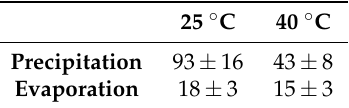
Table 7. The number of unit cells needed to have a total stack potential of 1.33 V and an operating current density at peak power.